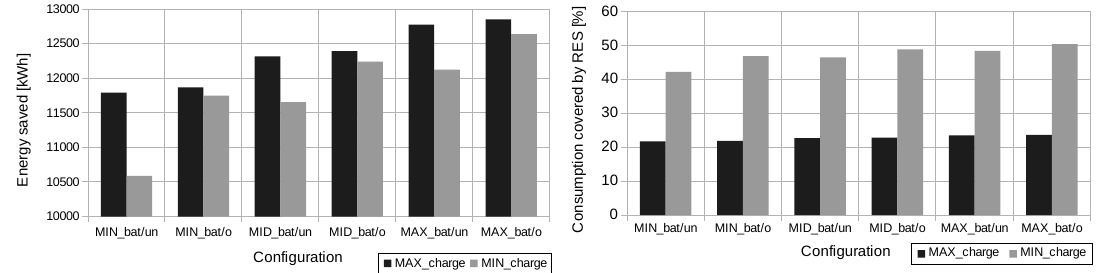
Figure 7. Comparison of different battery setups and charging scenarios on a year-long